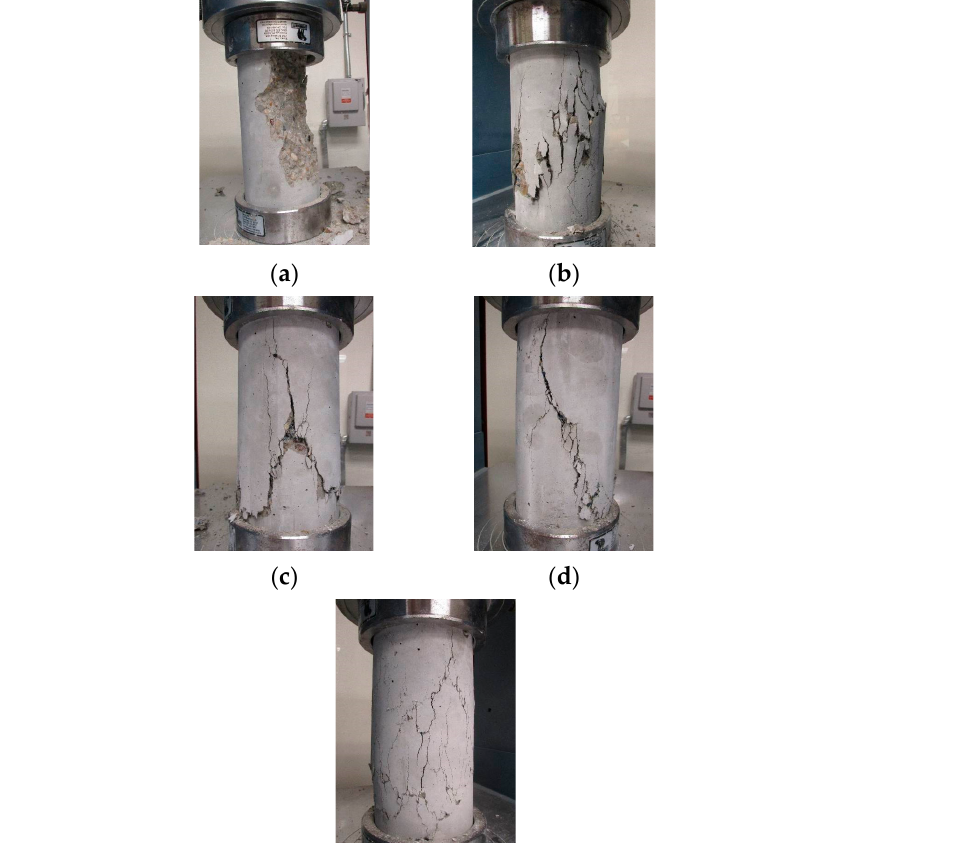
Figure 15. Modes of failure of concrete specimens with different CR contents. ( a ) 0% content of CR. ( b ) 5% content of CR. ( c ) 10% content of CR. ( d ) 15% content of CR. ( e ) 20% content of CR.